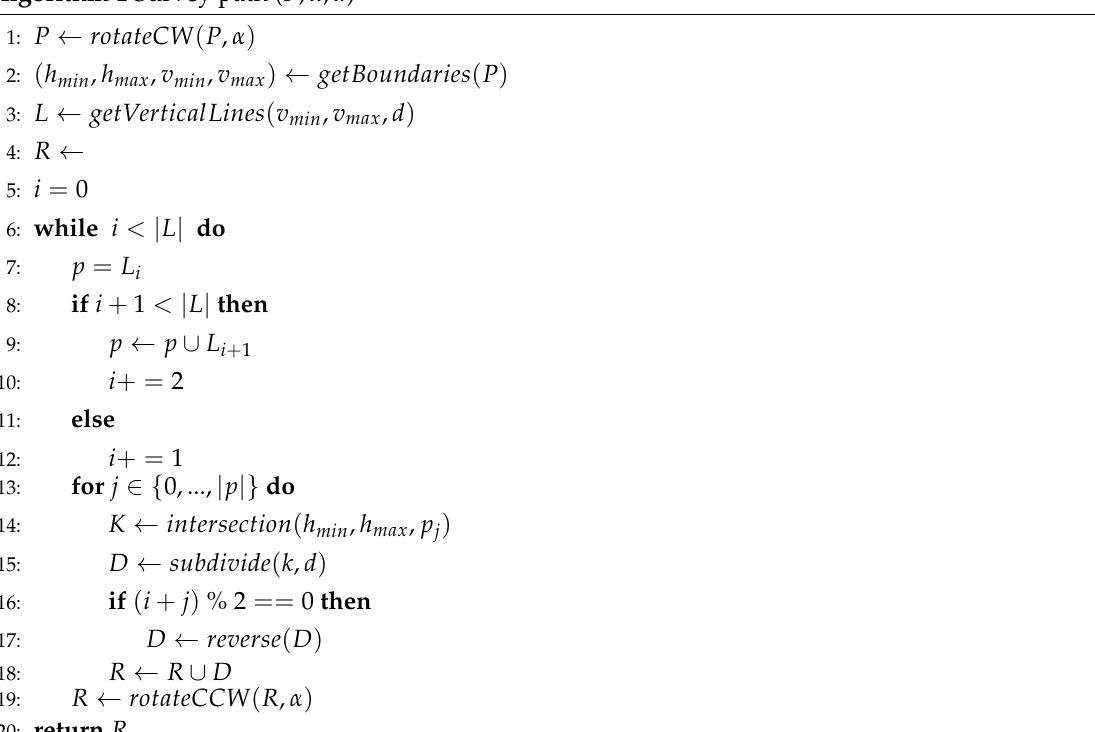
Algorithm 1 Survey path ( P , α , d